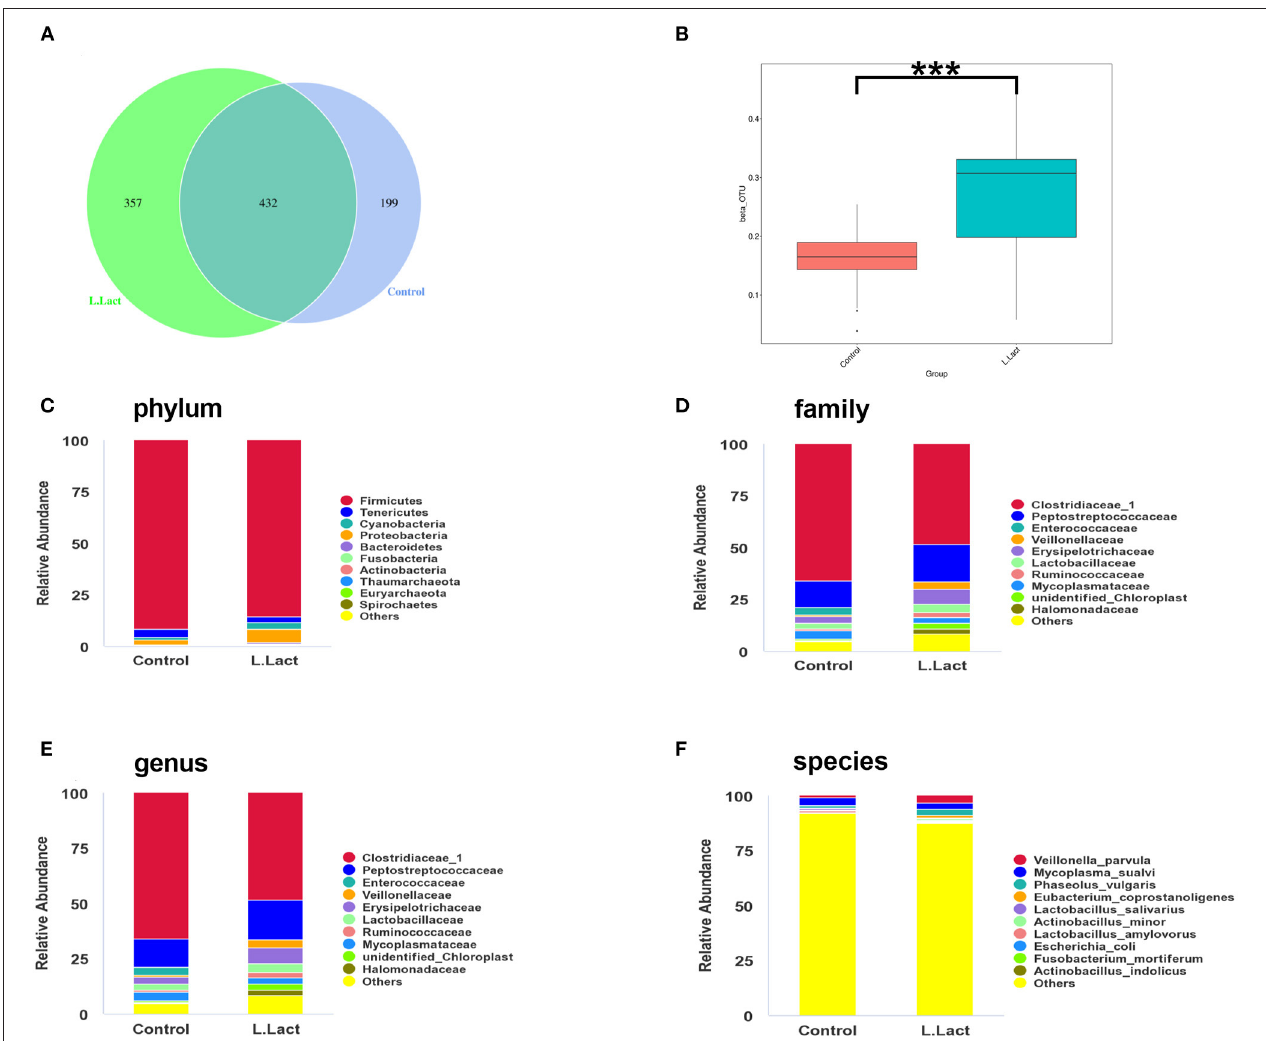
FIGURE 4 | Effects of L.lactis on ileal microbiota of the piglets. (A) The Venn diagram shows the common and unique OTUs of the control and L.lactis groups. (B) Rank abundance curves of beta diversity in the control and L.lactis groups. (C–F) Relative abundance of top 10 phyla (C) , families (D) , genera (E) , and species (F) in the control and L.lactis groups. *** P <